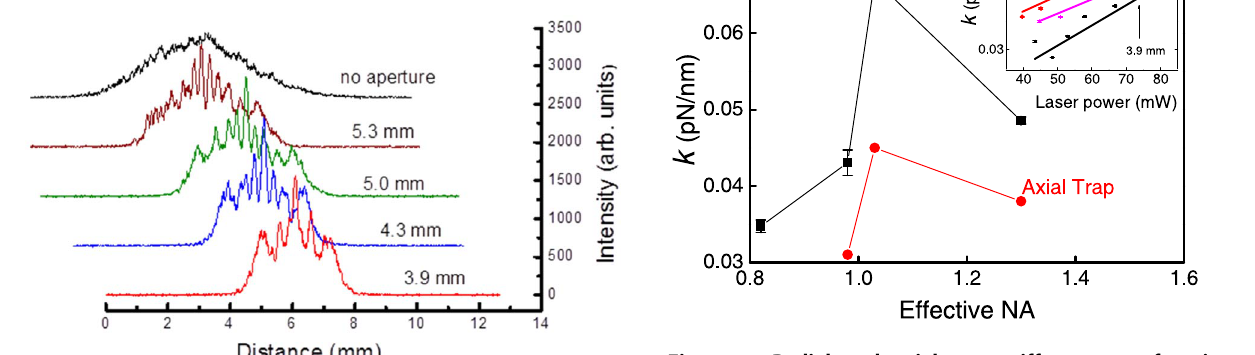
Figure 4. Radial and axial trap stiffness as a function of effective numerical aperture (NA) for 70 mW incident laser power. The inset shows the radial trap stiffness as a function of incident laser power for different apertures.